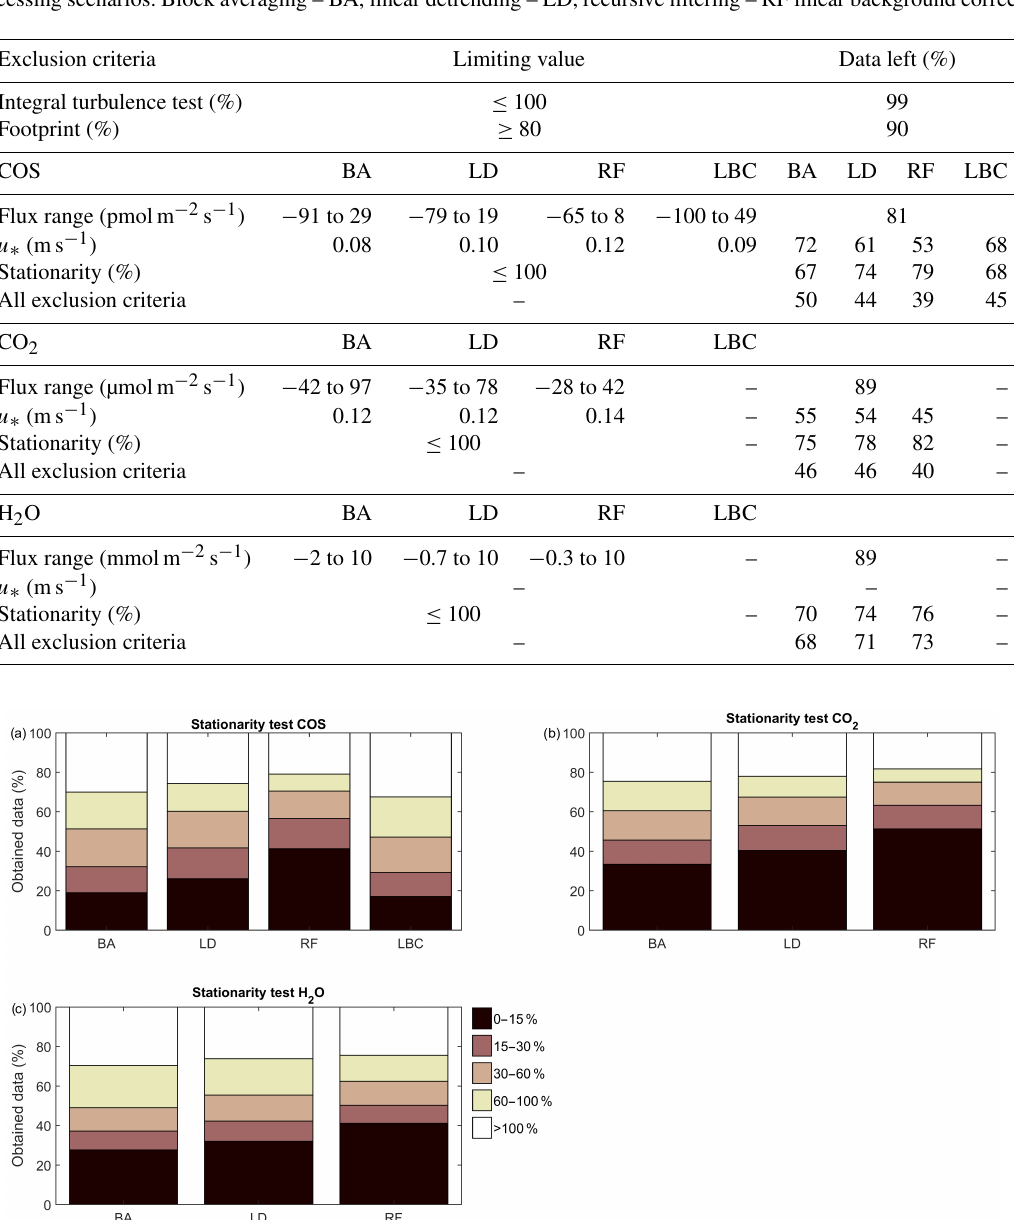
Table 1. List of flags, their limiting values and the percentage of data left after application, for each gas. The first two criteria pertain to all gases and processing scenarios. Block averaging – BA, linear detrending – LD, recursive filtering – RF linear background correction – LBC).